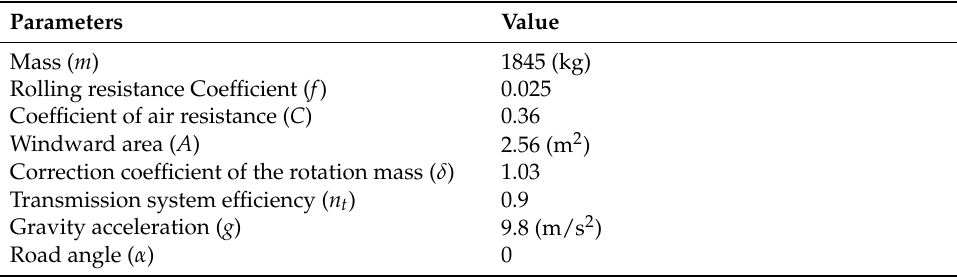
Table 1. Main characteristic parameters of